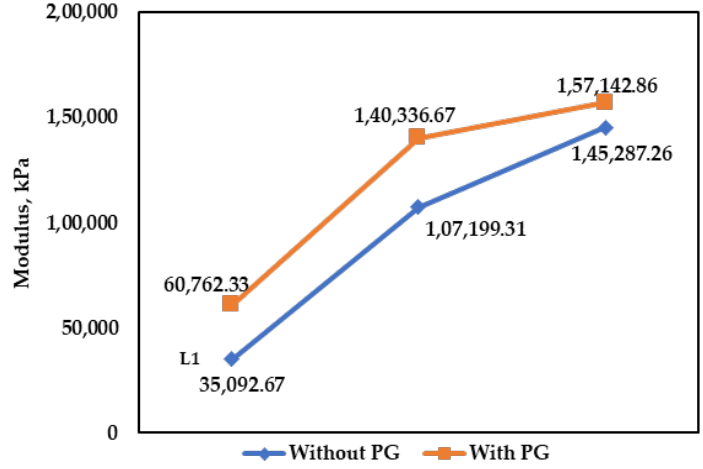
Figure 2. Contribution of PG to the modulus in lime modified soil.